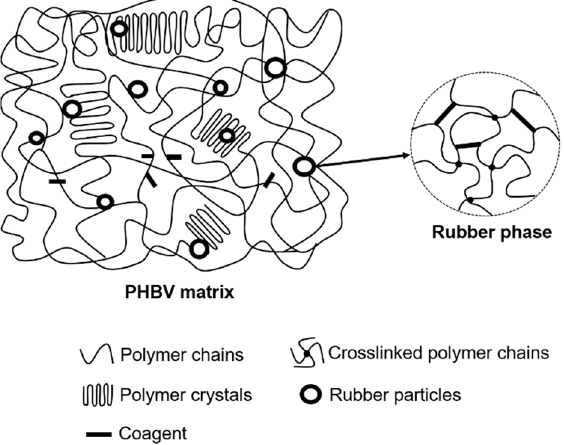
Figure 11. A conceptual structure of a coagent-assisted peroxide-cured PHBV/NR blend.